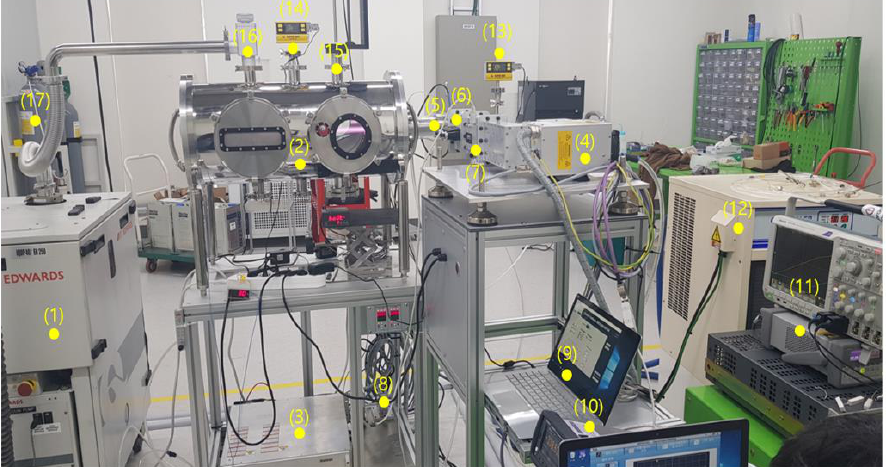
Figure 1. The µ -PAD experimental set-up. Components of the µ -PAD system are (1) dry vacuum pump, (2) vacuum chamber, (3) microwave power, (4) magnetron head, (5) plasma source, (6) 3-stub tuner, (7) bidirectional power meter, (8) MFC, (9) monitoring system, (10) data acquisition system, (11) measurement system, (12) oil chiller, (13) & (14) convection pirani vacuum gauge, (15) electric probe, (16) angle valve, and (17) argon bombe.